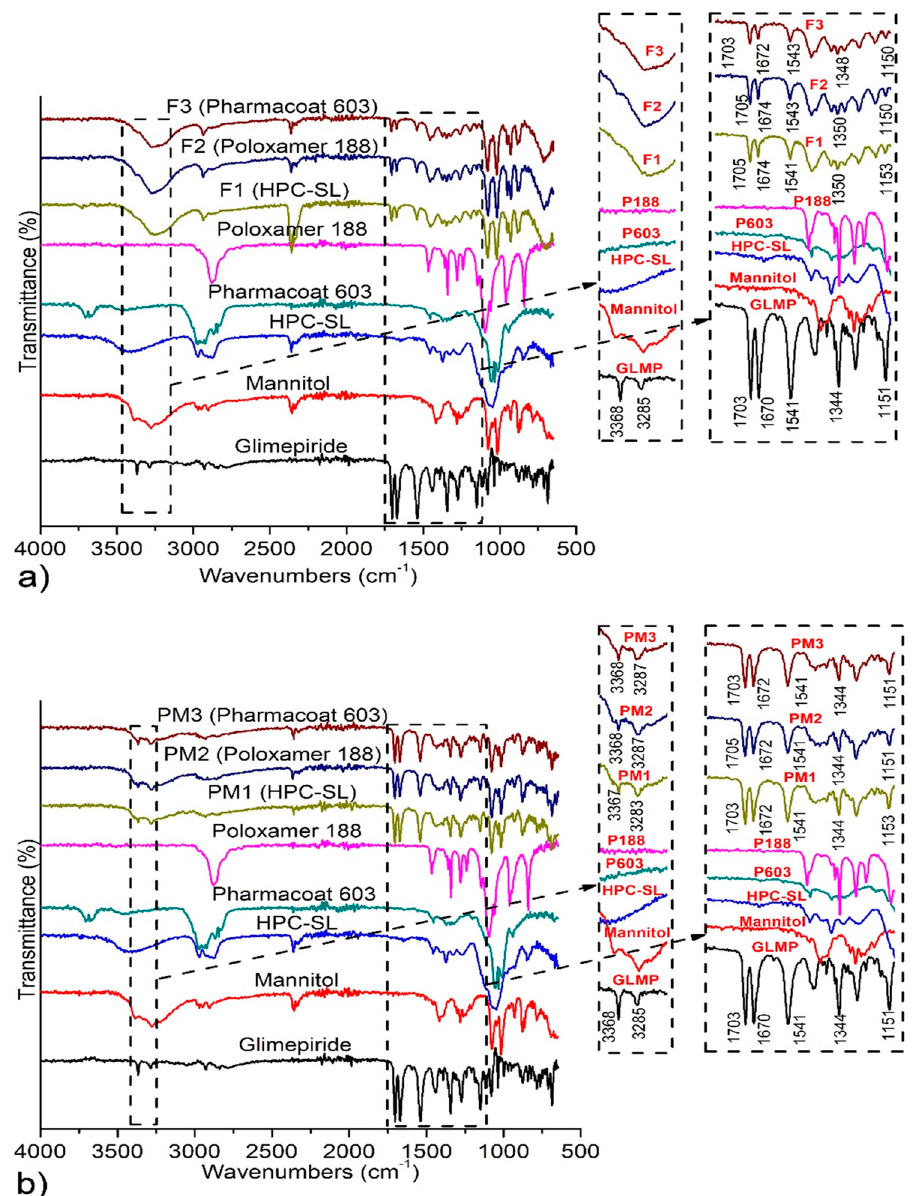
Figure 3. FT-IR spectra of: ( a ) Raw materials, spray dried nanosuspensions (F1–F3) and ( b ) corresponding physical mixtures (PM1–PM3). GLMP stands for Glimepiride, P603 for Pharmacoat ® 603, and P188 for poloxamer 188.